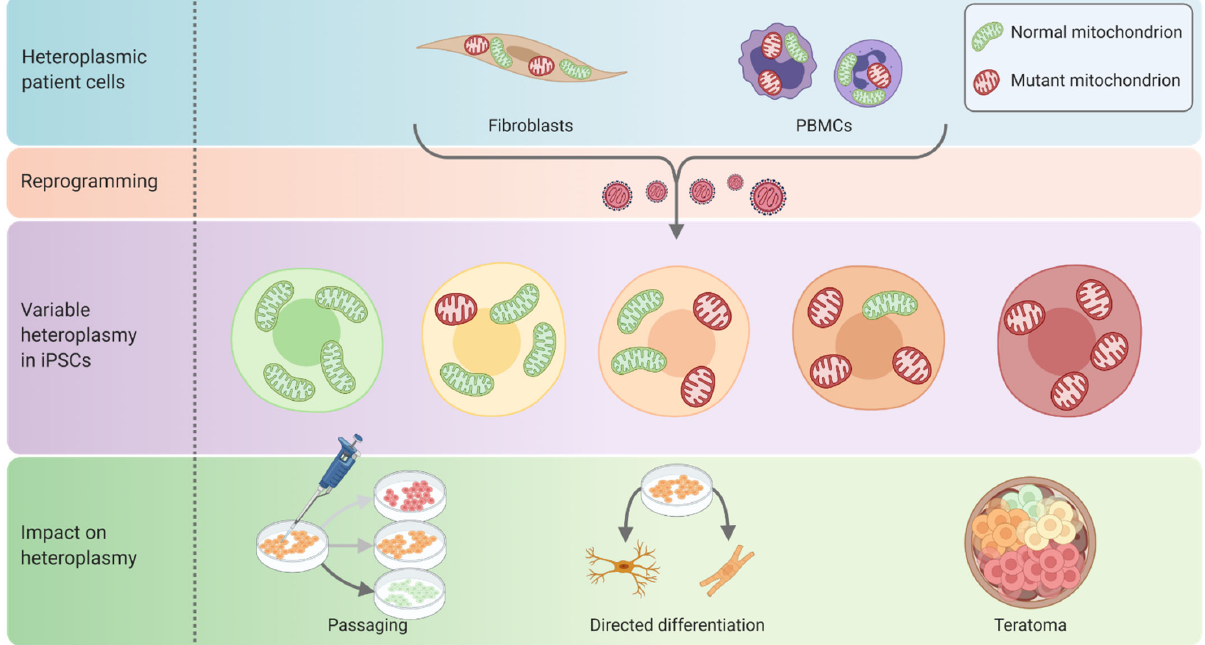
Figure 4. Maintenance of mtDNA heteroplasmy in iPSCs. Generation of iPSC lines from patient cells with mtDNA mutations can result in a shift in heteroplasmy from the somatic cell levels in either direction [21,66], although biased toward loss of mutant load [45,89]. Similarly, heteroplasmy can shift in either direction as heteroplasmic iPSC lines (orange cells) are passaged, with a general bias towards a decreased mutant load over time (green cells, lower mutant load; red cells, higher mutant load) [45,69,87,90]. During directed differentiation, heteroplasmy is typically unchanged from the level observed in the undifferentiated iPSCs [21,91,92]. However, during teratoma assays, different cell lineages can end up manifesting cell ‐ type specific OXPHOS defects that may depend on the specific mtDNA mutation [21,93]. These biases appear to be selective, with mechanisms such as genetic bottleneck and genetic drift only playing a minor role [91].